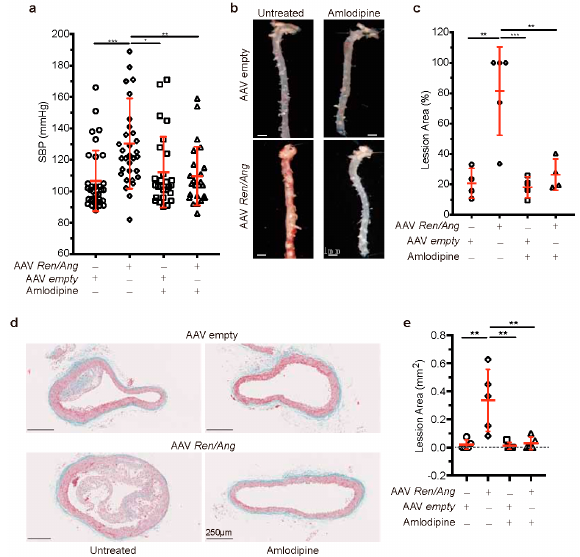
Figure 4. The calcium antagonist amlodipine reduces blood pressure (BP) and atherosclerosis induced by AAV- Ren/Ang transduction in mice. ( a ) SBP (mmHg) in ApoE − / − mice injected with AAV-empty shuttle vector or AAV- Ren/Ang . Mice were maintained for 10 weeks on the high-fat diet (HFD) starting 6 weeks after AAV injection and were untreated or treated with amlodipine (2.5 mg/kg) in the drinking water. SBP was measured at the same time of the day in all groups. Data are mean ± SEM. * p < 0.05, ** p < 0.01, *** p < 0.001, 2-way ANOVA followed by Bonferroni post-test (n = 10 per group). ( b ) Representative Oil Red O-stained aortas from AAV-empty shuttle vector and AAV- Ren/Ang -injected ApoE − / − mice untreated or treated with amlodipine throughout the 12-week HFD period. Scale bar, 1 mm. ( c ) Lesion area in aortas stained as in ( b ). Data are mean ± SEM. ** p < 0.01, *** p < 0.001, one-way ANOVA with Tukey’s multiple comparison test (n = 4-5 mice per group). Each data point represents an individual aorta, horizontal red bars denote mean values, and black bars denote SEM. ( d ) Representative Masson’s trichrome staining of descending aorta sections from ApoE − / − mice injected with empty vector or AAV- Ren/Ang and untreated or treated with amlodipine. ( e ) Lesion area in sections stained as in d. Data are mean ± SEM. ** p < 0.01, one-way ANOVA with Tukey’s multiple comparison test (n = 4–5 mice per group). Each data point represents an individual aorta, horizontal red bars denote mean values, and bars denote